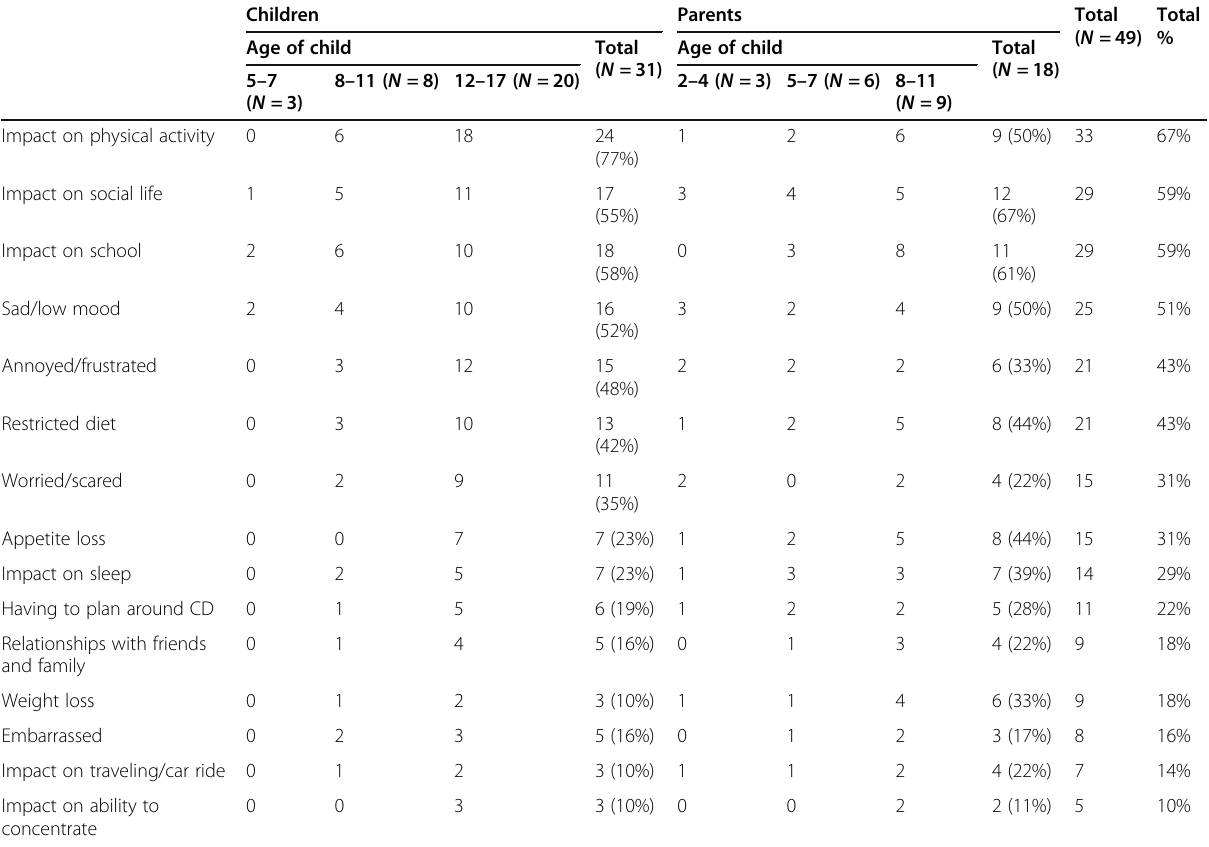
Table 4 HRQL Impacts Reported by ≥ 10% of Study Participants Children